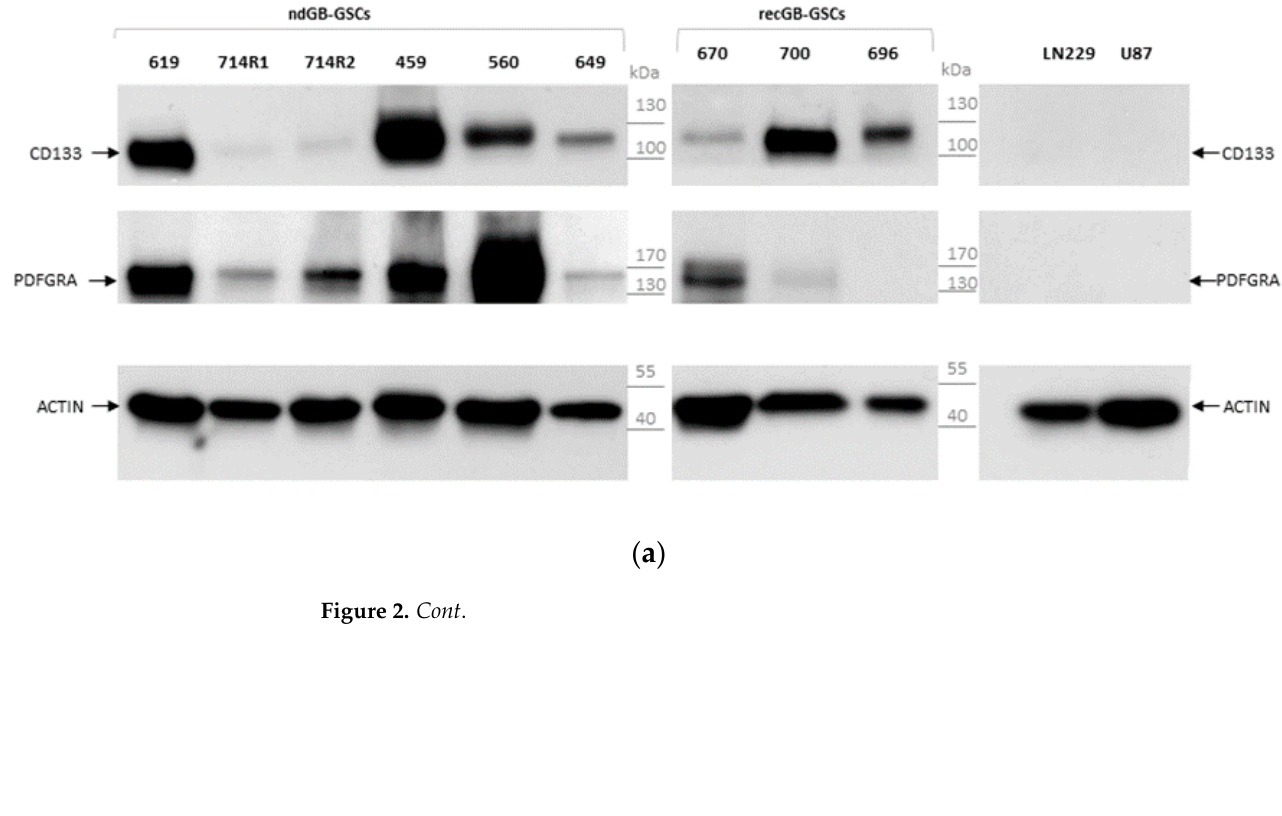
Figure 1. Immunohistochemical co-staining of GB tissues reveals either segregated ( a ) or concomitant ( b ) expression of ALDH1A1 and ALDH1A3 in tumor cells. Magnification 40 × . Scale bar, 100 µ m.